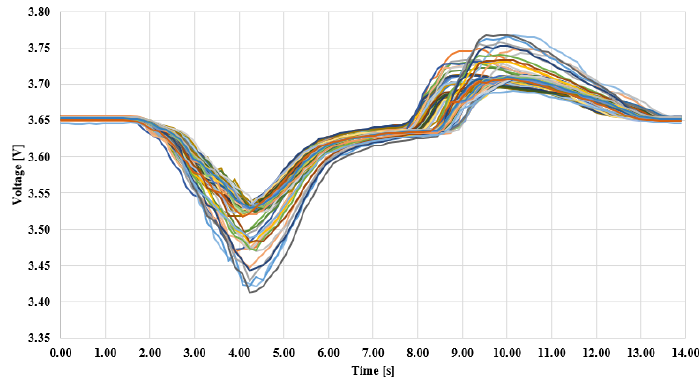
Figure 14. The voltage of the e-Golf system during the test cycles (the different color lines indicate the 88 battery cells).